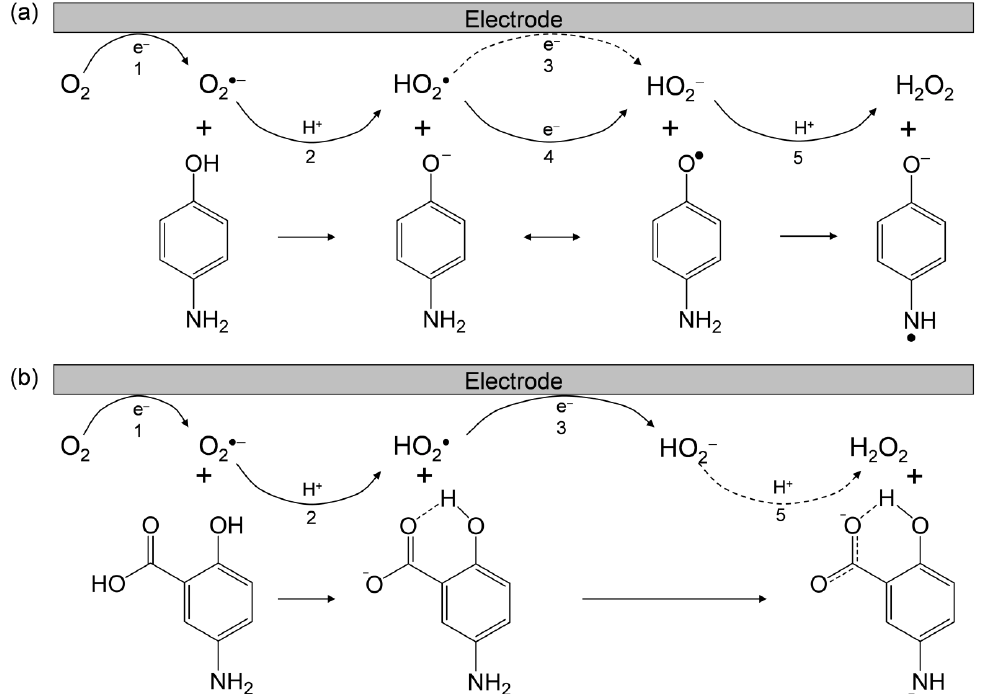
Figure 3. Plausible electrochemical mechanisms for O 2 /O 2 •− in the presence of ( a ) p -AP and ( b ) 5-ASA in DMF. 1 One- electron reduction of O 2 /O 2 •− ; 2 initial proton transfer (PT) from the acidic substrate to O 2 •− ; 3 one-electron reduction